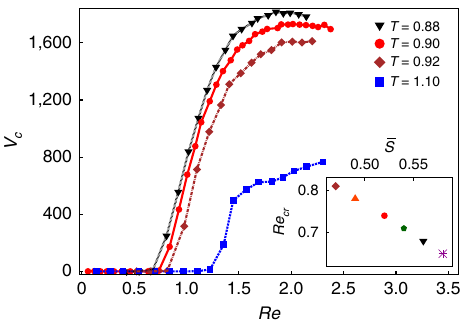
Figure 5 | Growth of cavitation volume. Cavitation volume plotted against Reynolds number Re for the nematic LC at T ¼ 0.88 (black triangle), at T ¼ 0.90 (red circle) and at T ¼ 0.92 (brown diamond), and for an isotropic LC (blue square). The inset shows the critical Reynolds number, Re cr , plotted against the average nematic order parameter (cid:3) S , spanning temperatures from T ¼ 0.92 down to T ¼ 0.87.